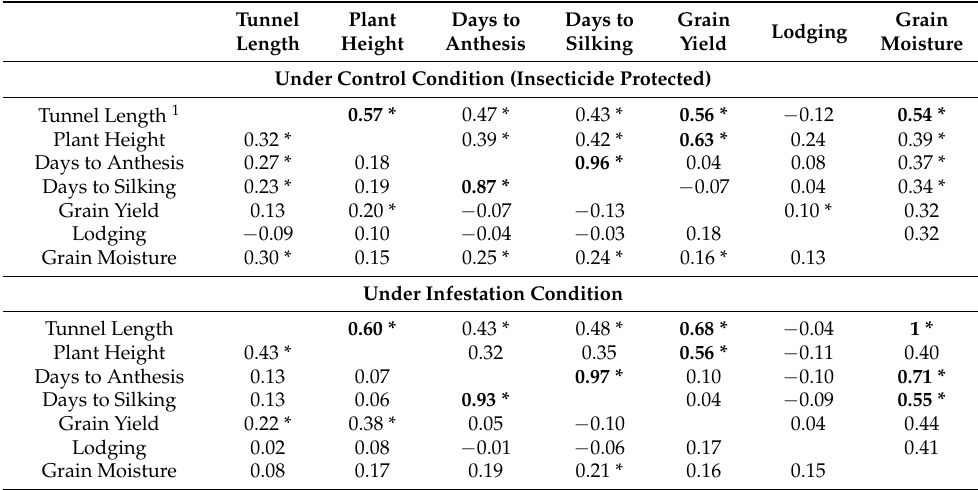
Table 2. Genotypic (above diagonal) and phenotypic (below diagonal).